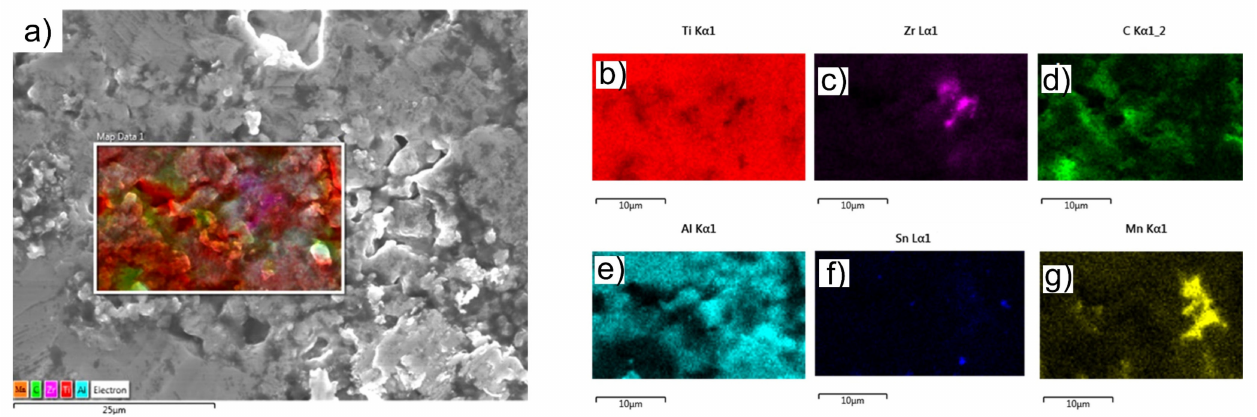
Figure 8. SEM image and EDXS elemental mapping for the sample obtained by TSS: ( a ) SEM image and overlayed maps, ( b ) Ti, ( c ) Zr, ( d ) C, ( e ) Al, ( f ) Sn and ( g ) Mn map